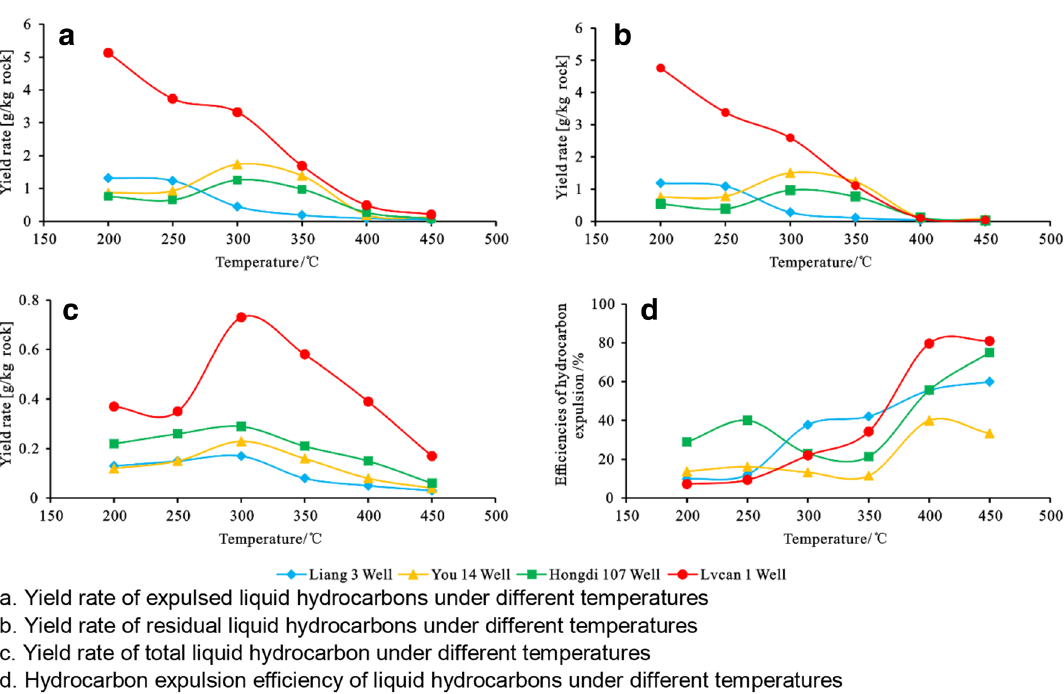
Fig. 3 Thermal simulation of hydrocarbon expulsion of Paleogene– Neogene source rocks in the Western Qaidam Basin. a Yield rate of expulsed liquid hydrocarbons under different temperatures. b Yield rate of residual liquid hydrocarbons under different temperatures.